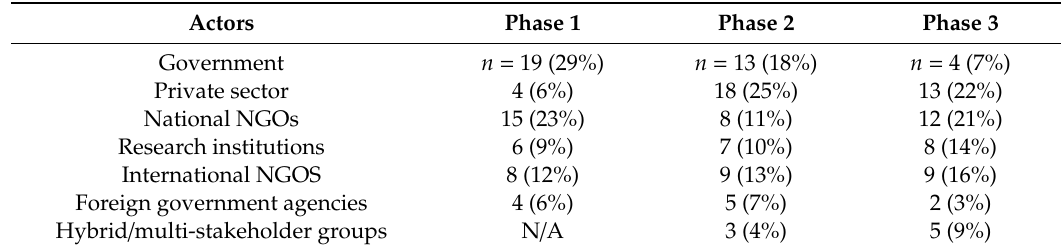
Table 2. Number of policy actors in di ff erent